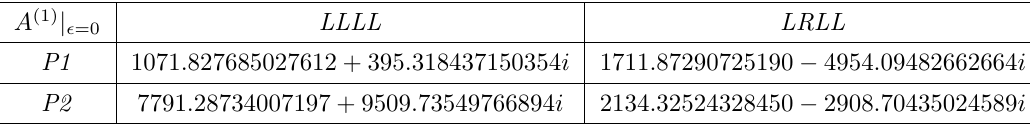
Table 3. Evaluation of the two independent helicity amplitudes at one loop for the phase space points defined in eq. (5.2) and eq.